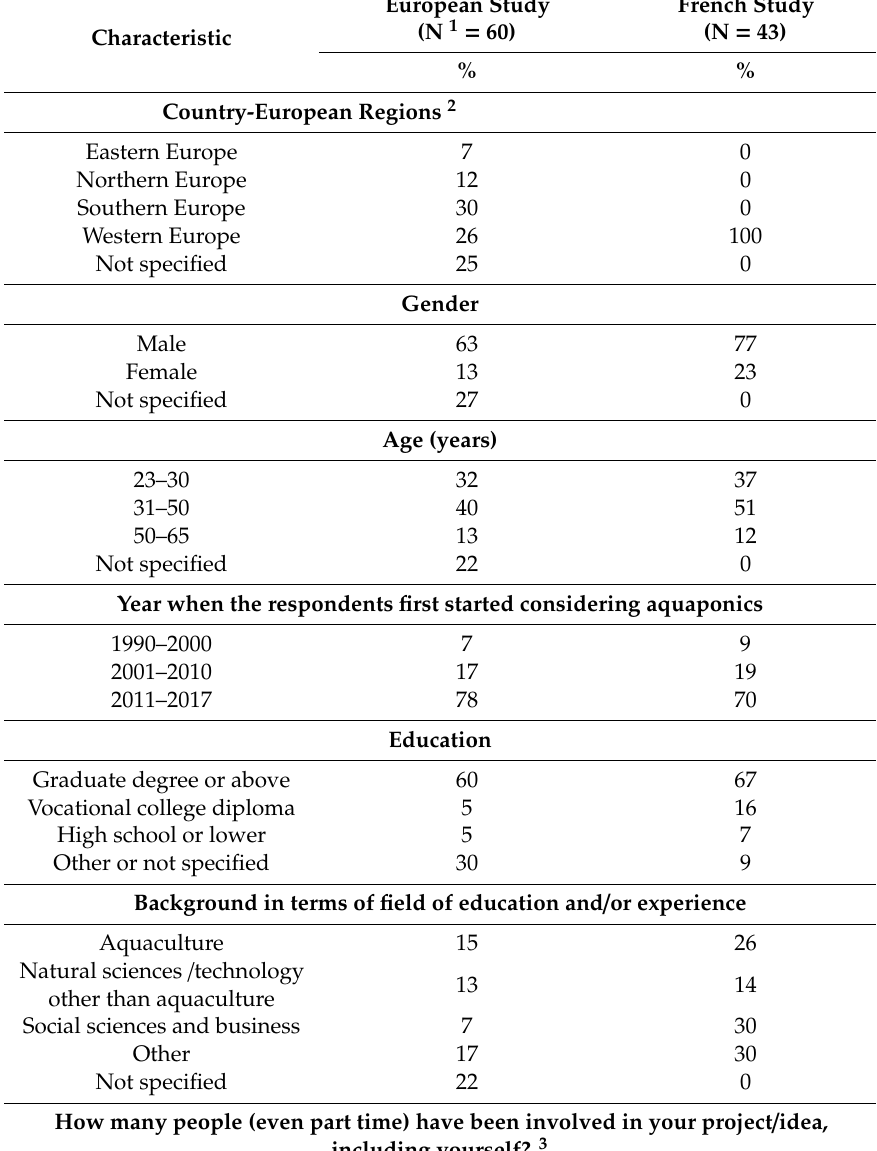
Table 1. Demographic characteristics of participants, education and background, years of familiarity with aquaponics, and team size.